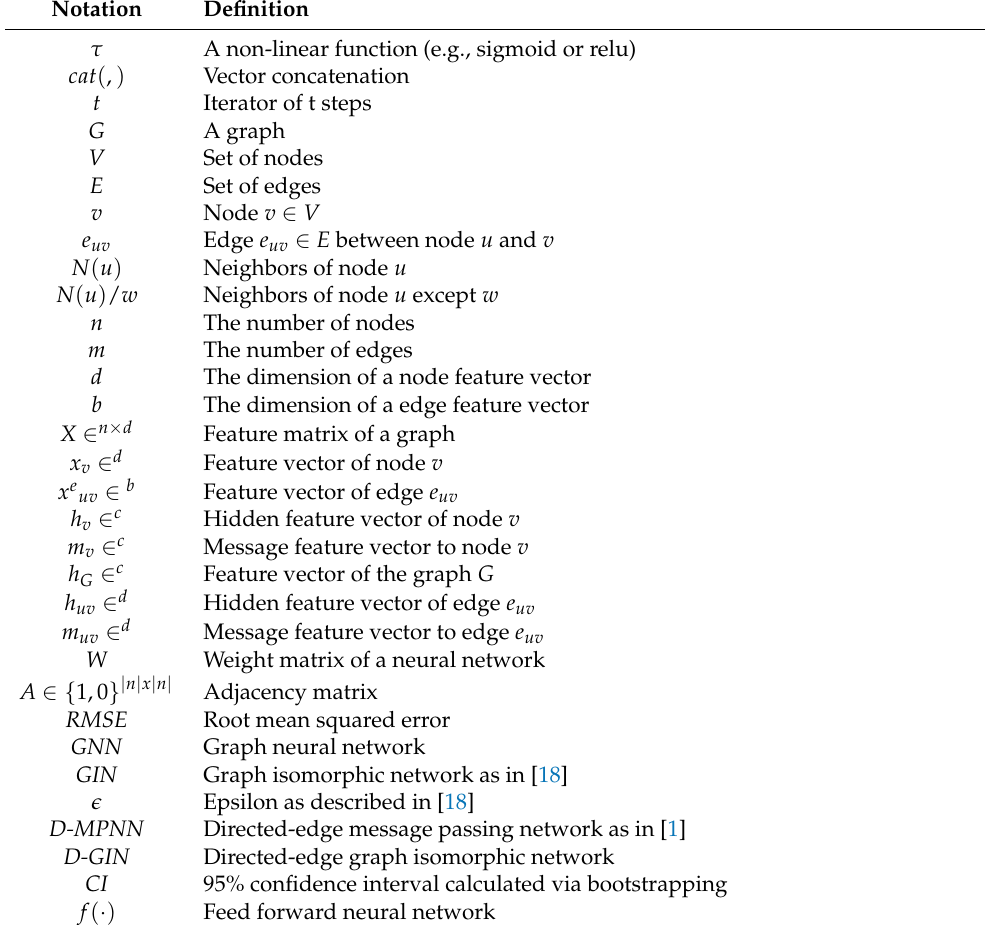
Table 1. Common notations used throughout this